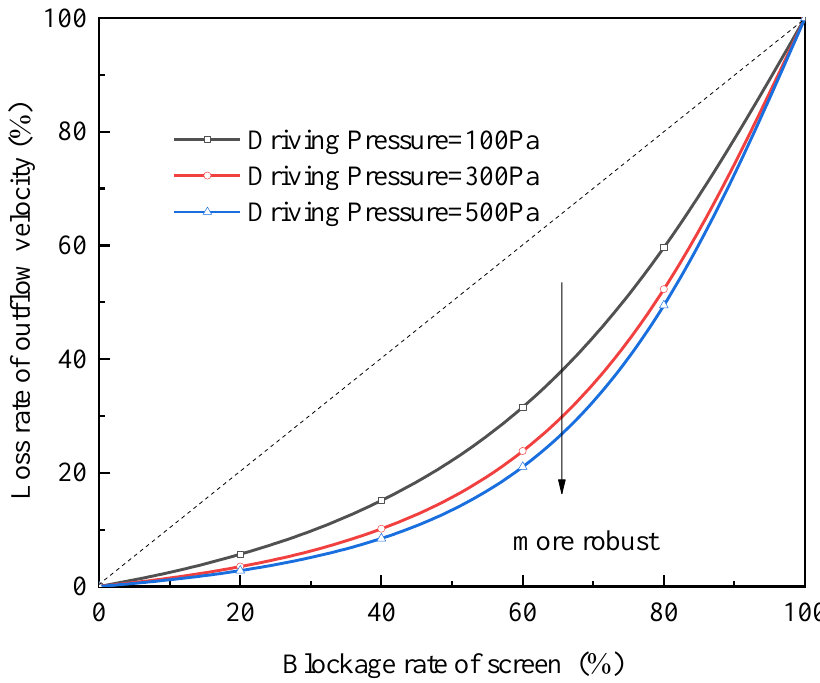
Figure 10. Characteristic curves influenced by driving pressure. Interestingly, all the cases represented by three curves show greater robustness than that by the dashed line (in which the outflow velocity decreases proportionally with the blockage area). To interpret this, when a part of the screen is blocked, other un- blocked parts would get higher local injection velocity to compensate for this loss of liquid acquisition